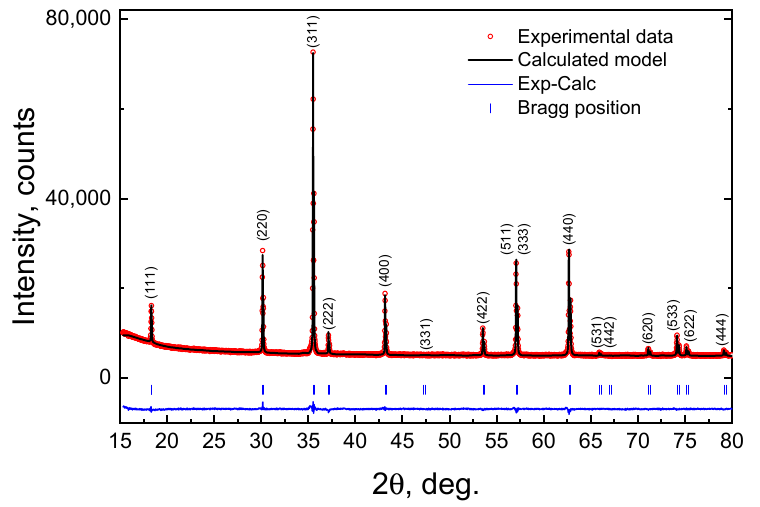
Figure 1. The powder XRD pattern of the polycrystalline Fe 2+ Cr 3+ 1.75 Fe 3+ 0.25 O 4 sample at room temperature (red circles) and its Rietveld refined model curve (black curve).